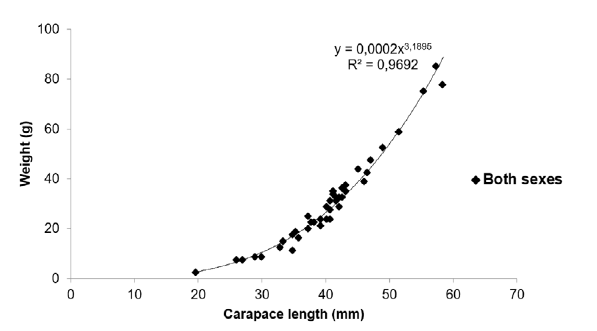
Figure 3. Relationship between carapace length and weight of Atya gabonensis Giebel, 1875 in the Fluvial Island Domain in the Paraíba do Sul River basin.